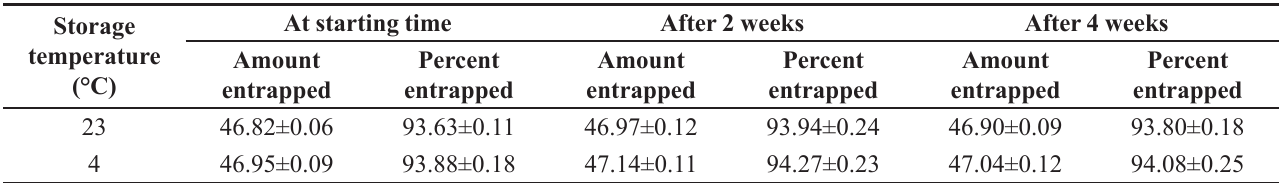
TABLE II - Drug entrapment and size entrapment of MFA- DDC liposomes kept in different storage conditions Storage